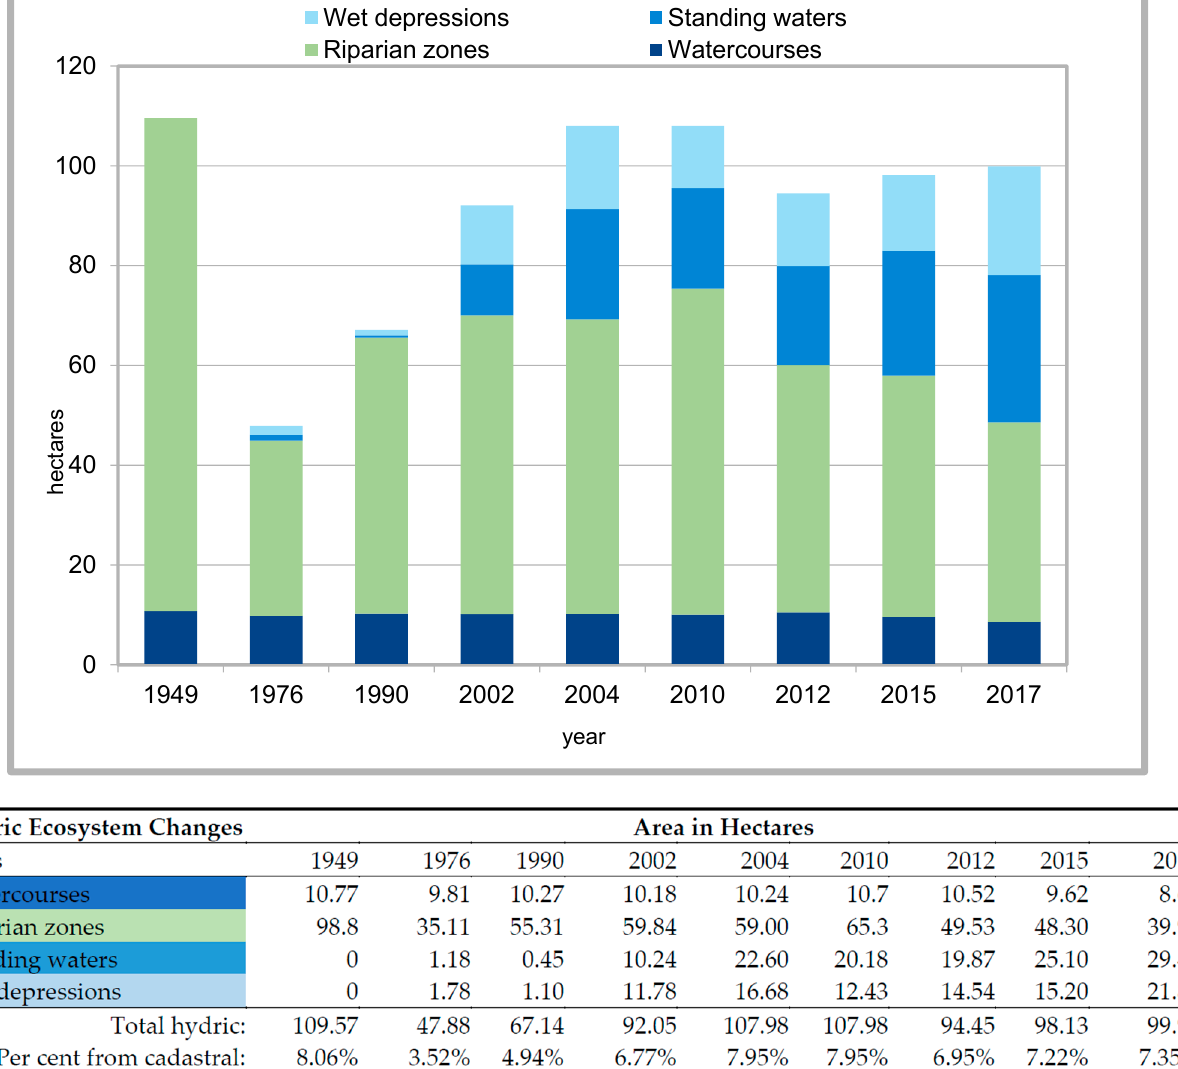
Figure 3. Hydric ecosystem changes.